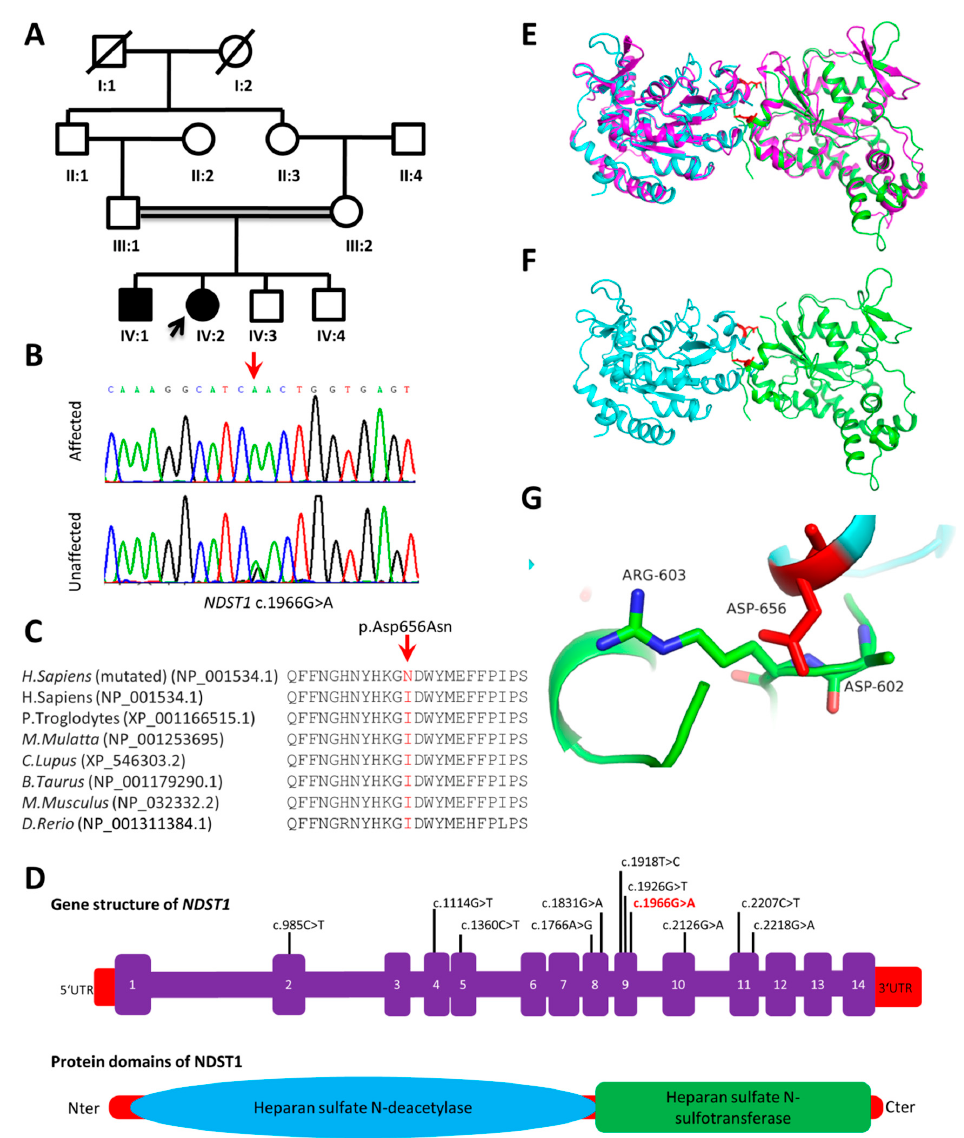
Figure 2. ( A ) Pedigree of family A, exhibiting an autosomal recessive inheritance. Males are represented by squares, females by circles. Filled and unfilled symbols illustrate the a ff ected and una ff ected individuals, respectively. A diagonal line over a circle or square represents deceased individuals. Consanguinity is represented by double lines ( = ). ( B ) Sanger sequencing results of family A. The red arrow indicates the localization of the variant. ( C ) Conservation of Asp656 across di ff erent species. The sequence shown is part of the heparin sulfate N-sulfotransferase domain. ( D ) Gene structure and protein domains of NDST1. Known variants are indicated on the gene structure. The c.1966G > A variant is shown in red. ( E ) Modeling the NSDT1 dimer structure using 3-O-sulfotransferase as a template (colored as magenta). Two copies of NSDT1 (green and cyan) are superimposed to the two domains of 3-O-sulfotransferase. The Asp656Asn mutation site is shown as a red stick model. ( F ) The dimer structure of NSDT1 without the 3-O-sulfotransferase template. The Asp656Asn mutation lies on the binding interface. ( G ) The proximal interaction between Asp656Asn and the Asp602 and Arg603 residues on the other interacting domain.